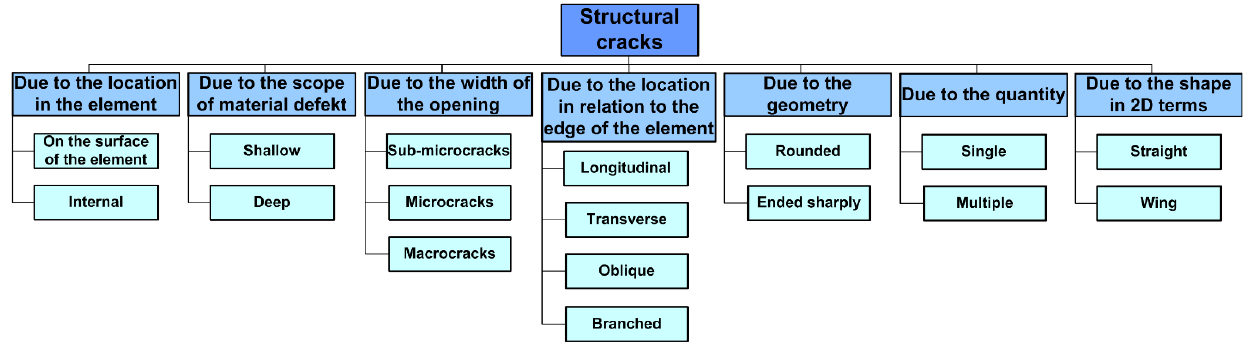
Figure 4. Breakdown of structural cracks in concrete.